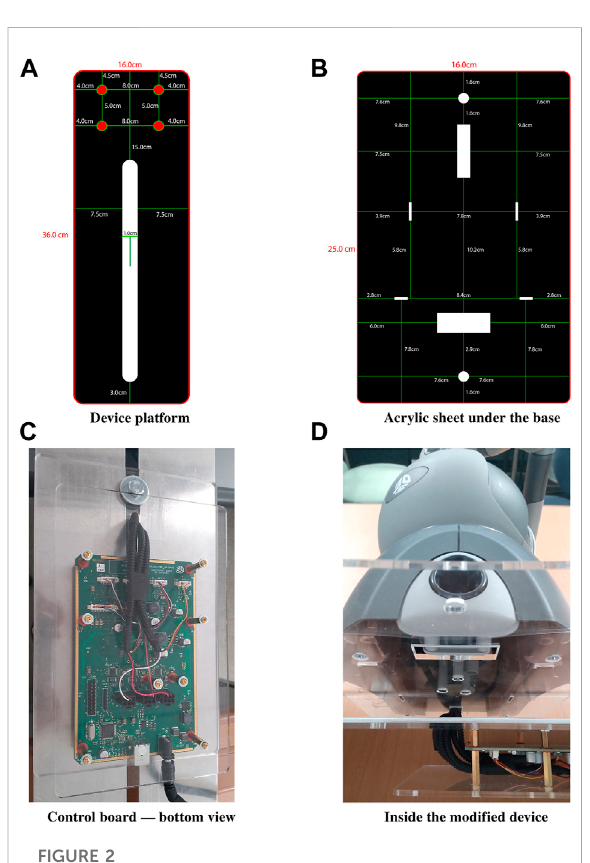
FIGURE 2 Force-feedback device modi fi cations: (A) device platform; (B) acrylic sheet under the base; (C) control board — bottom view; and (D) inside the modi fi ed